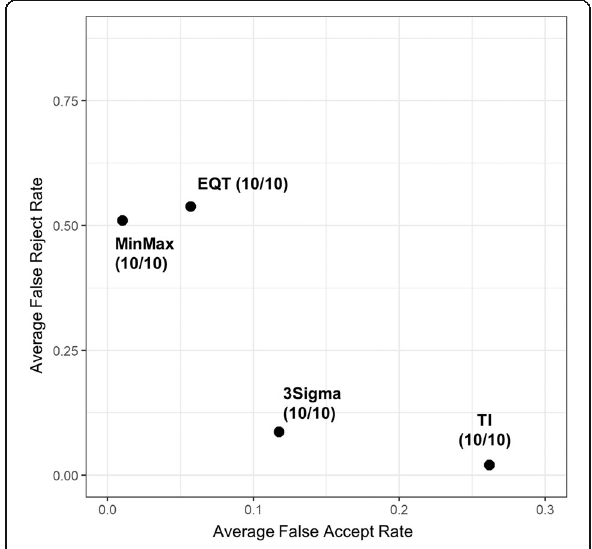
Fig. 2 Average operating characteristics: The average operating characteristics are shown for the tests MinMax, 3Sigma, equivalence testing of means and tolerance interval for a sample size of nref = 10 and ntest = 10. The horizontal axis represents the average false acceptance rate and represents the risk for a statistical false positive conclusion on similarity. The vertical axis represents the average false rejection rate and represents the risk for a statistical false